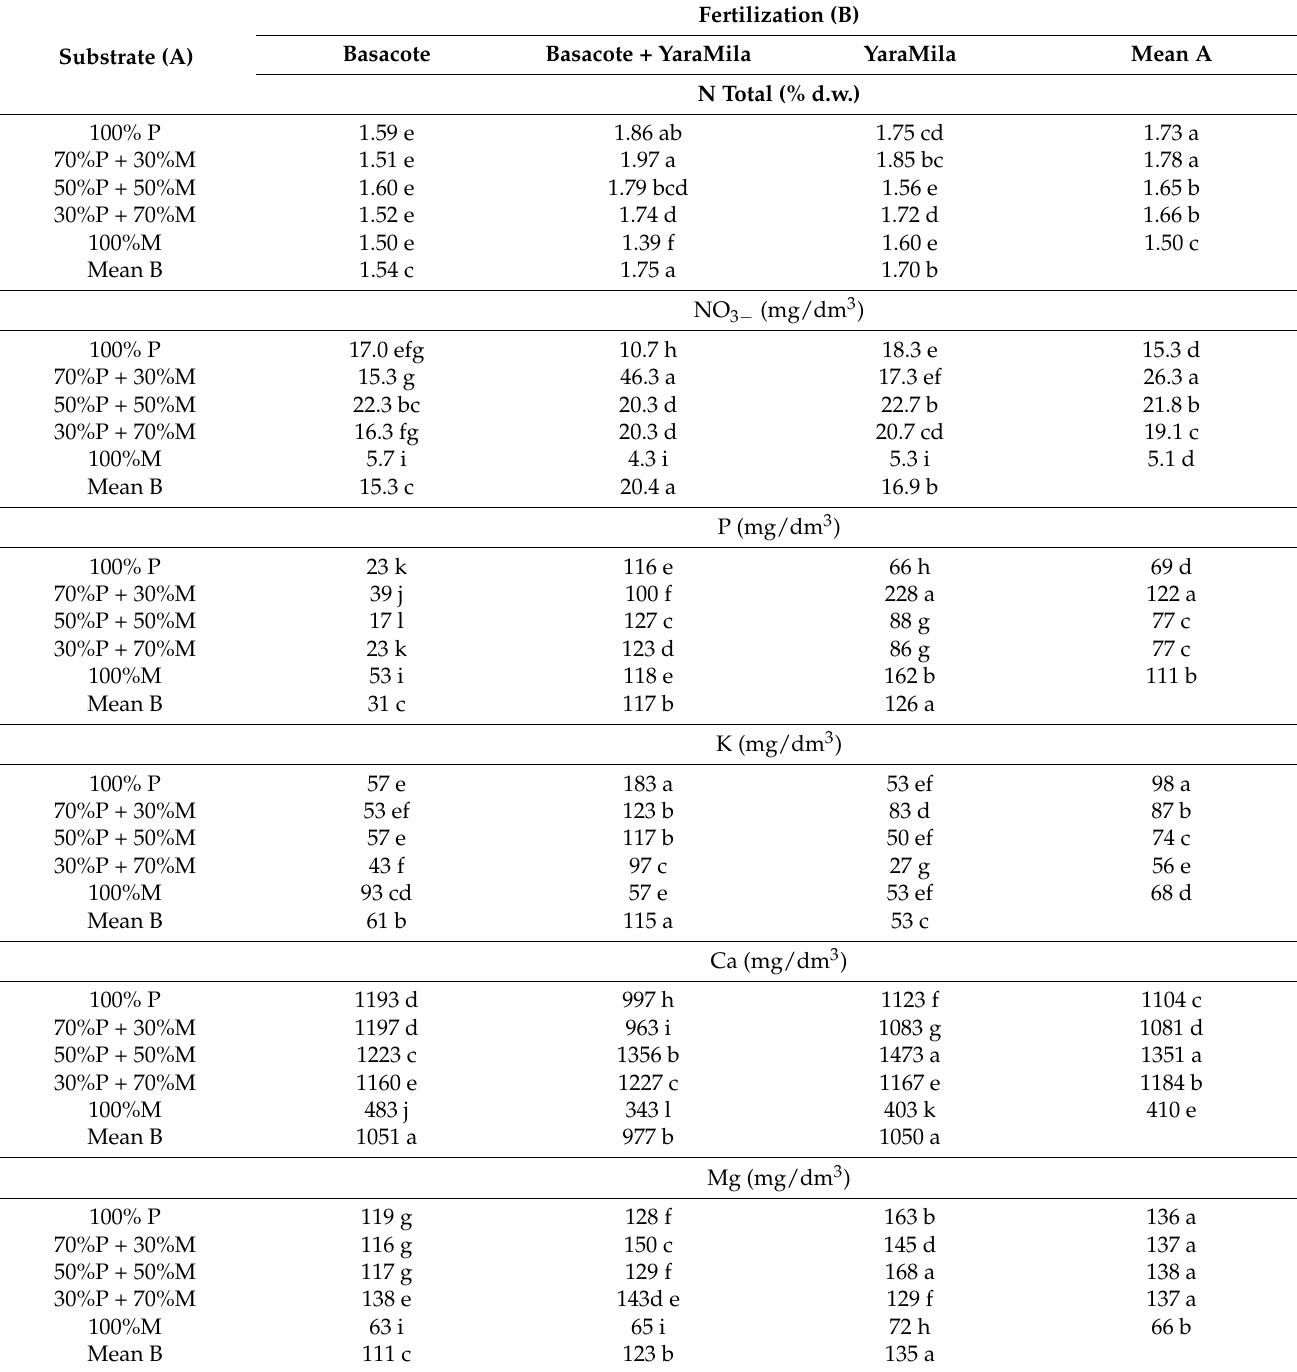
Table 14. Substrate nutrient contents in Sedum spectabile ‘Stardust’ grown in containers with five different